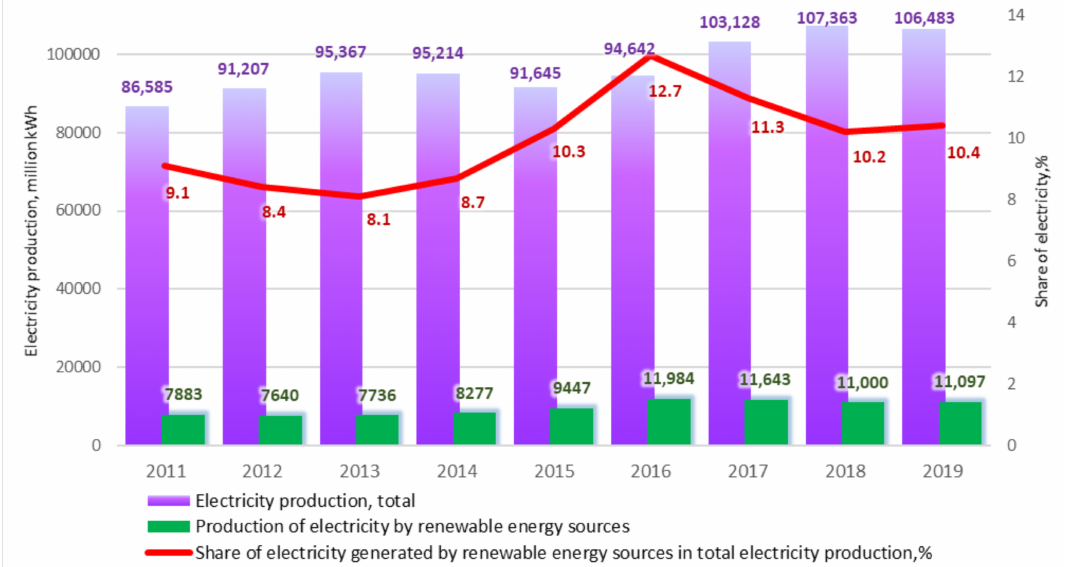
Figure 4. Dynamics of electricity production in Kazakhstan in 2011–2019, million kWh. Source: compiled by the authors based on data from